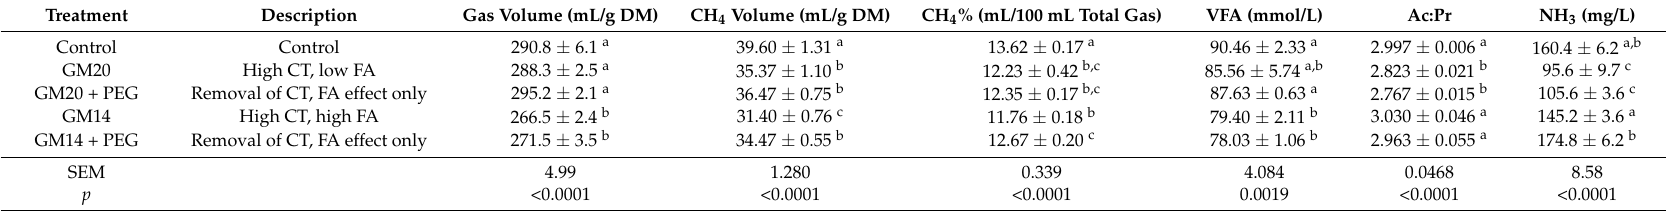
Table 4. In vitro fermentation parameters for Experiment 3; grape marc samples of differing fatty acid concentrations.